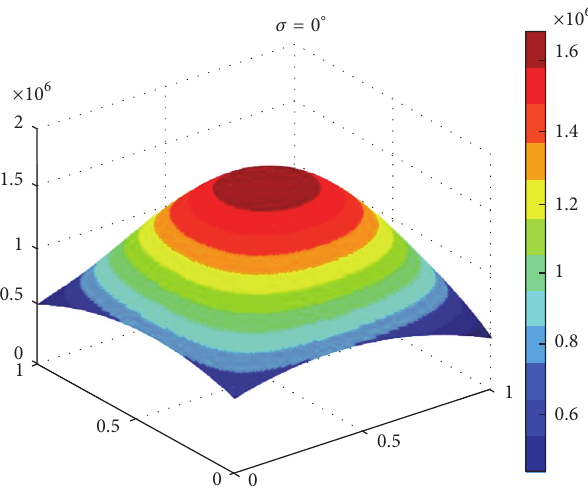
Figure 5: Flux distribution at deflection angle of 0 ∘ .